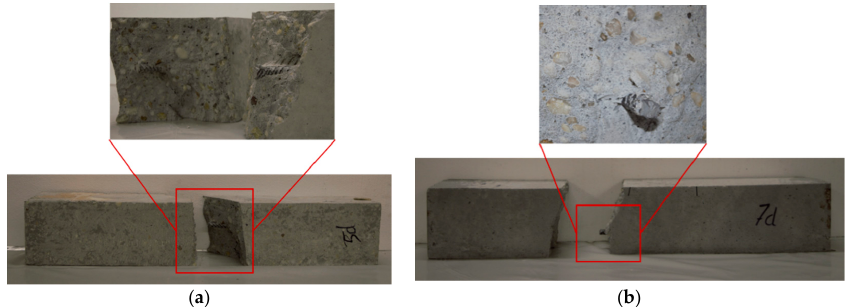
Figure 8. Modes of failure for lap splice: ( a ) bar slippage for lap splice length of 5d b ; ( b ) bar rupture for lap splice length of 7d b .